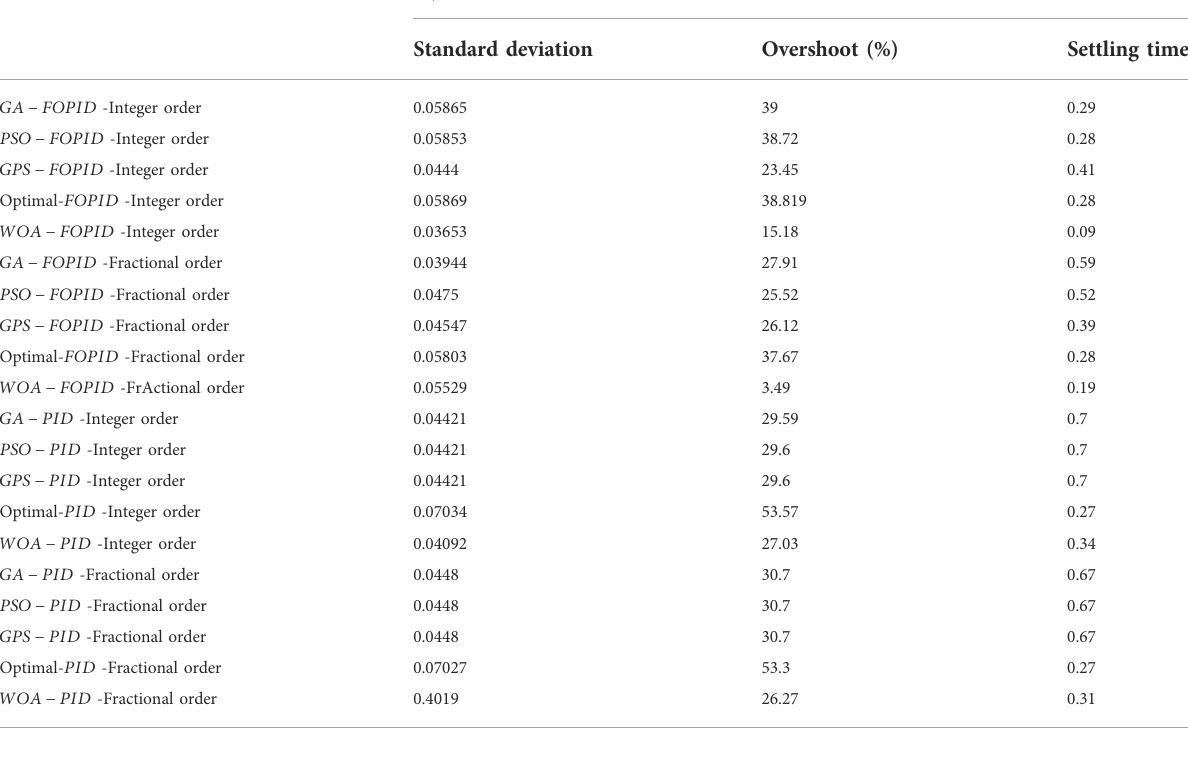
TABLE 3 Hydraulic motor ’ s parameter